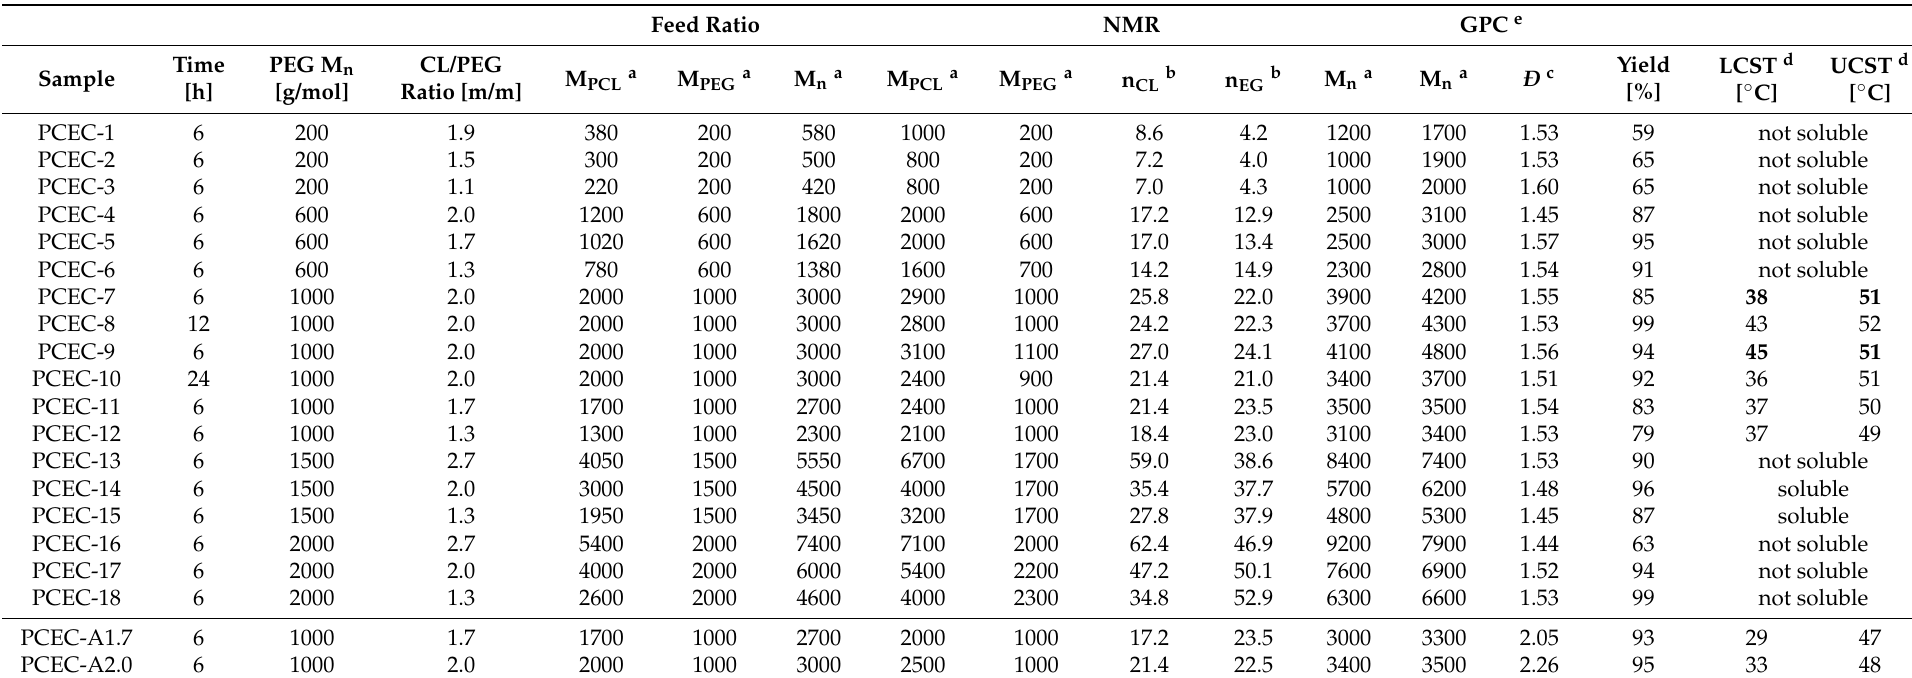
Table 1. PCEC triblock copolymers synthesis and